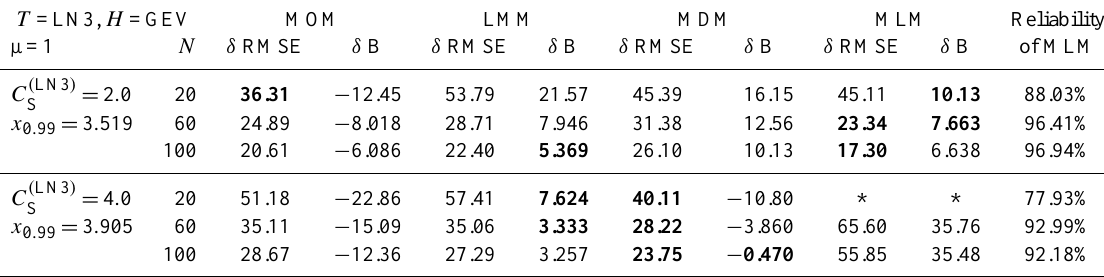
Table 9. Relative accuracy [ % ] of ˆ x 0 . 99 for a sample from LN3, assuming GEV model. T =LN3, H =GEV